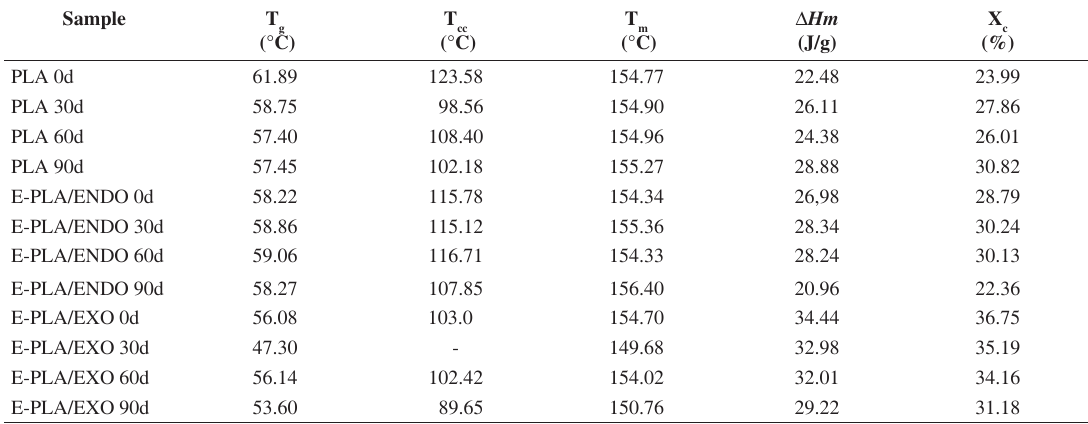
Table 2. Thermal characterization temperatures and crystallinity index for neat PLA and E- PLA/EXO and E-PLA/ENDO samples by DSC. Sample